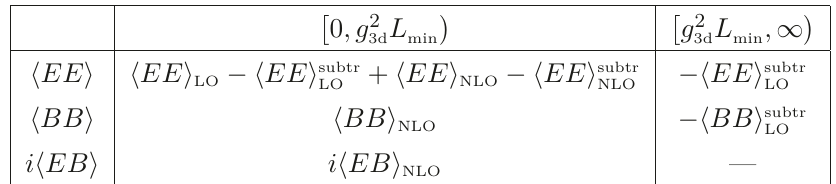
— Table 2 . Definition of ( Z 3d ) , as given in eq. (5.4). The second and third columns give the ct g integrands for the three contributions — which are to be added as per eq. (3.4) — in different intervals of g 2 L and with IR cutoff g 2 L . We recall that at leading order h BB i agrees with its LO 3d 3d min subtraction and i h EB i vanishes. Moreover, h BB i subtr and i h EB i subtr vanish since the respective LO NLO NLO correlators are UV-finite.